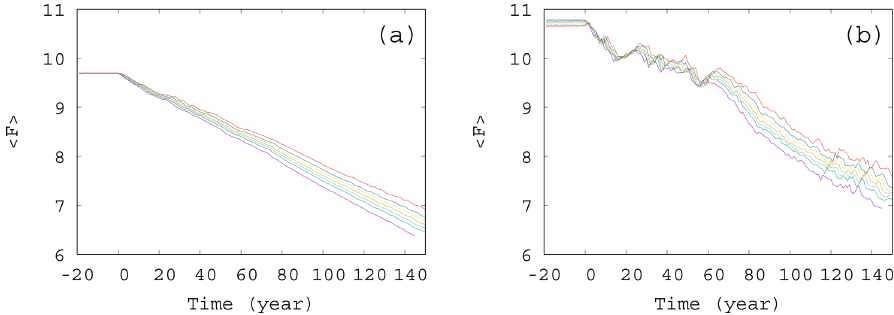
Figure 6. Time dependence of the average forcing < F > ( t ) in the case of (a) γ = 0 . 01 and (b) γ = 0 . 1. The values of the enrichment parameter from top to bottom are α = 0 . 2, 0.1, 0.05, 0, − 0 . 05, − 0 . 1, and − 0 . 2.